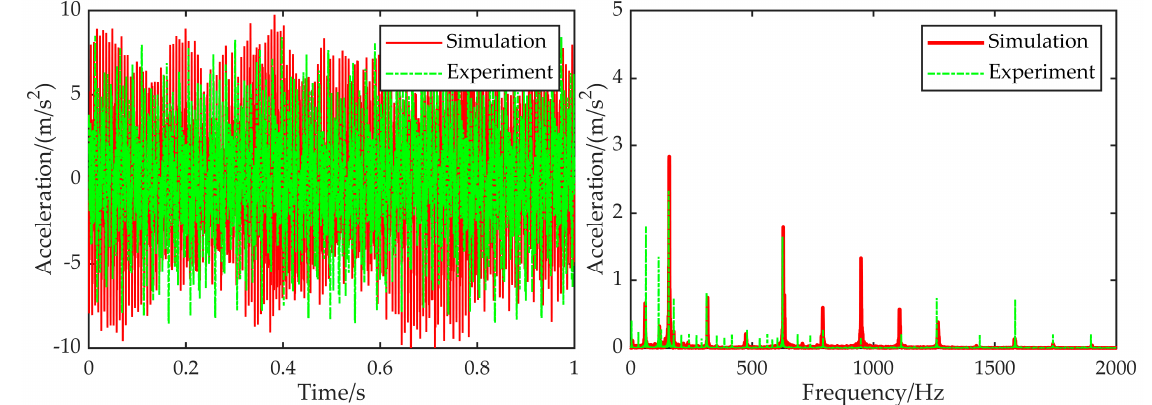
Figure 9. Comparison of the simulated and experimental results of the front chassis.